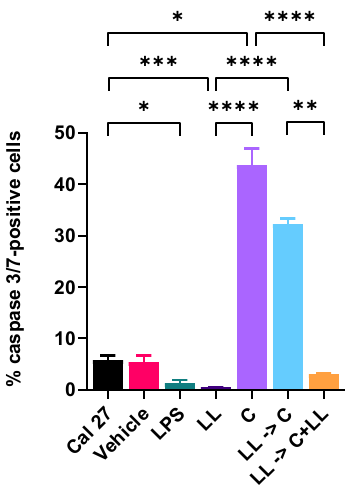
Figure 6. Percentage of apoptotic cells as determined by caspase 3/7-positivity. After Cal 27 cells were stimulated with LPS + LTA for 72 h, Cal 27 cells were treated with capsaicin for 24 h in the